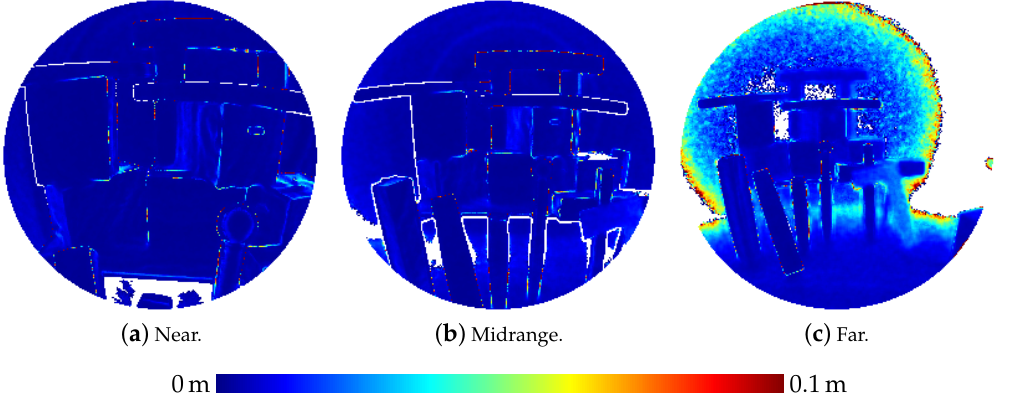
Figure 10. Noise of the range measurements of the HoloLens ToF sensor for the three-dimensional scene depicted in Figure 5 captured from three different